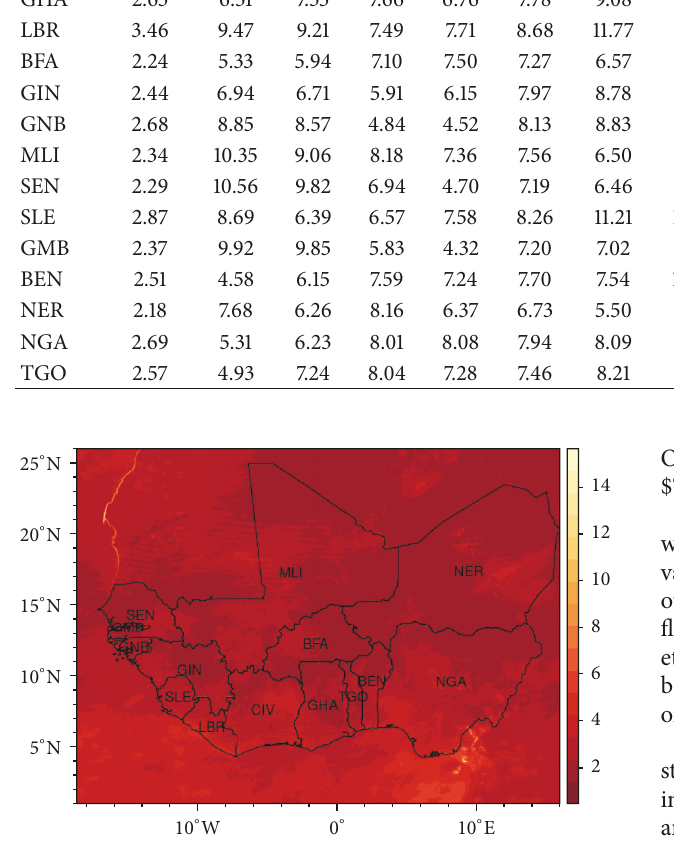
Figure 2: Annual solar resources coefficient of variation.